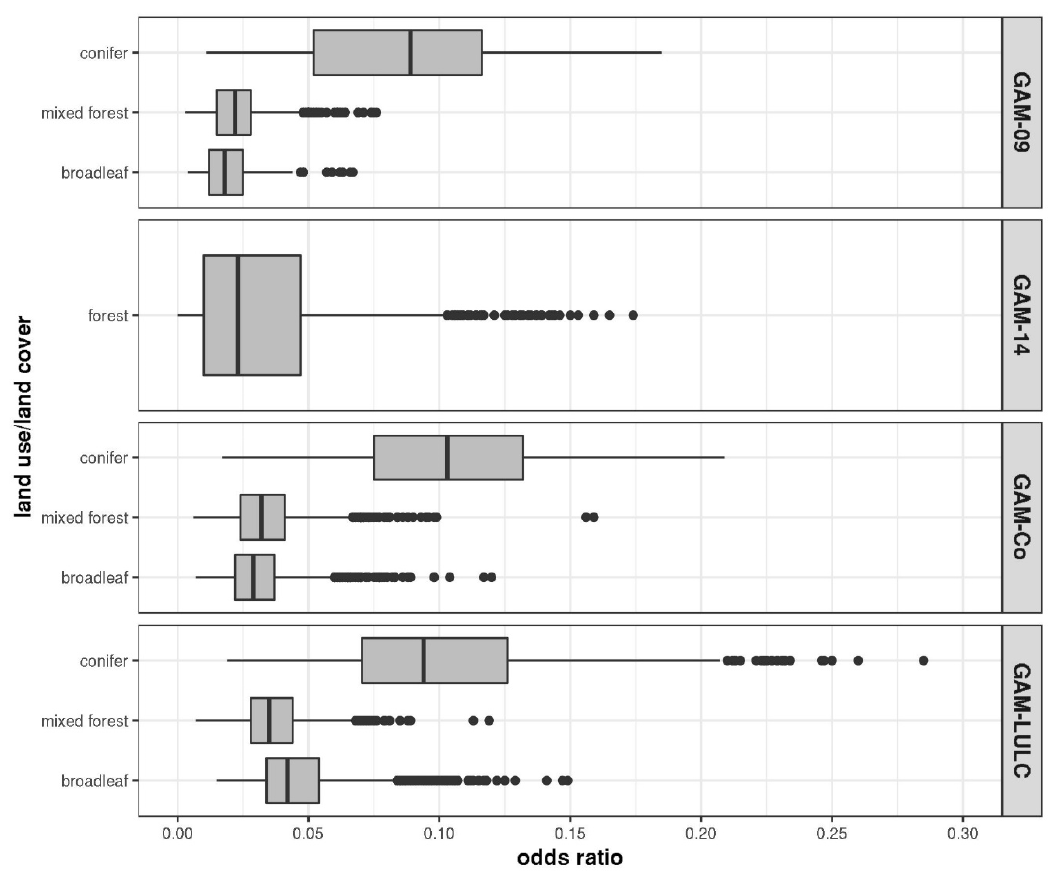
Figure7. RelationshipbetweenlandslideoccurrenceandLULCpredictorforesttypeintheSpCV-models Figure 7. Relationship between landslide occurrence and LULC predictor forest type in the SpCV- asestimatedbytheoddsratio. Onlysignificantrelationships( p -value < 0.05)wereselected. Thereference models as estimated by the odds ratio. Only significant relationships (p-value < 0.05) were selected. level is ‘no forest.’ Note that an odds ratio of 1 represents ‘no relationship’ and an odds ratio smaller The reference level is ´no forest.´ Note that an odds ratio of 1 represents ´no relationship´ and an odds than 1 is associated with lower odds of ratio smaller than 1 is associated with lower odds of outcome.